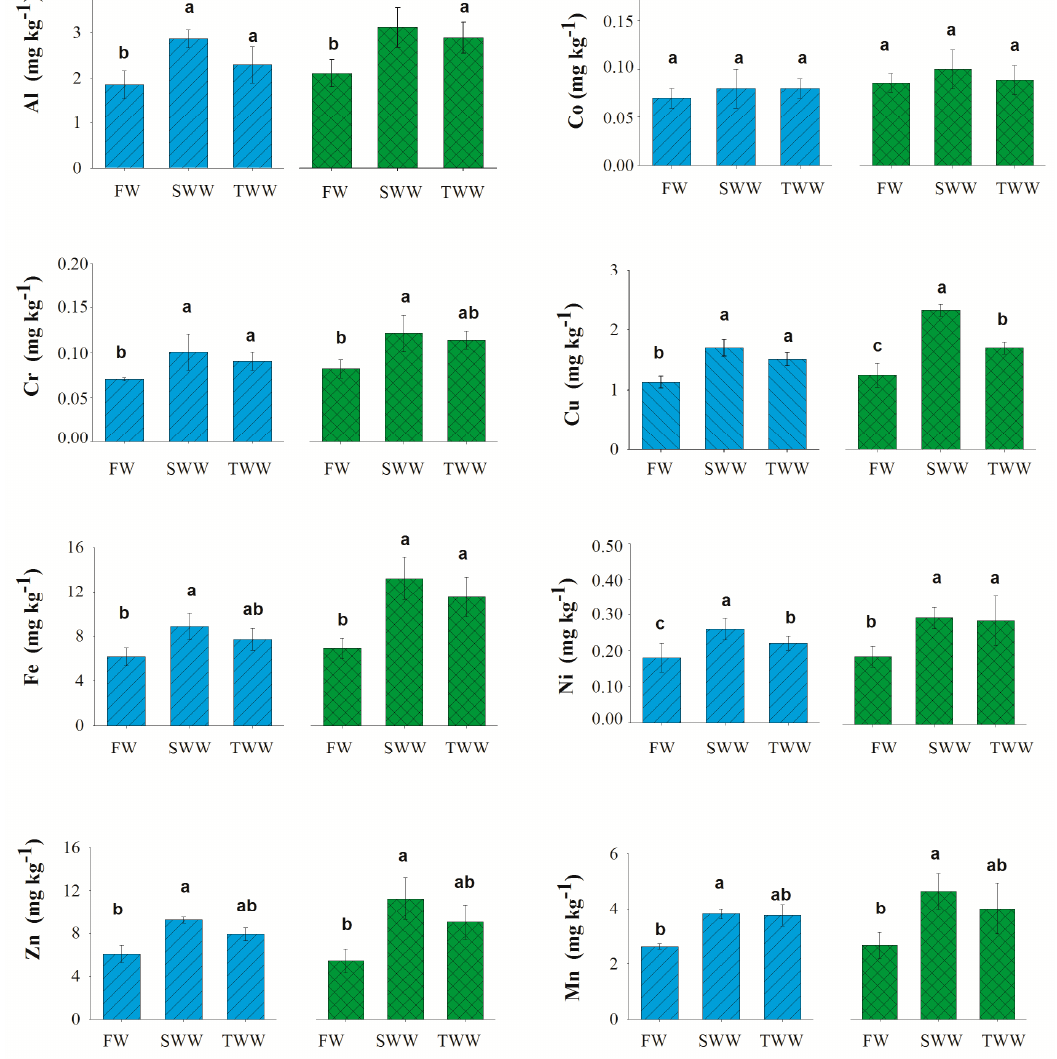
Figure 3. Heavy metal content of artichoke crops as plants (right, green bars) and as artichoke heads (left, blue bars), as a function of the type of irrigation water used. Different letters (a–b) indicate statistically significant differences ( p ≤ 0.05; Tukey’s test). The vertical bars indicate standard errors ( n = 6, 3 replicates × 2 growing seasons).